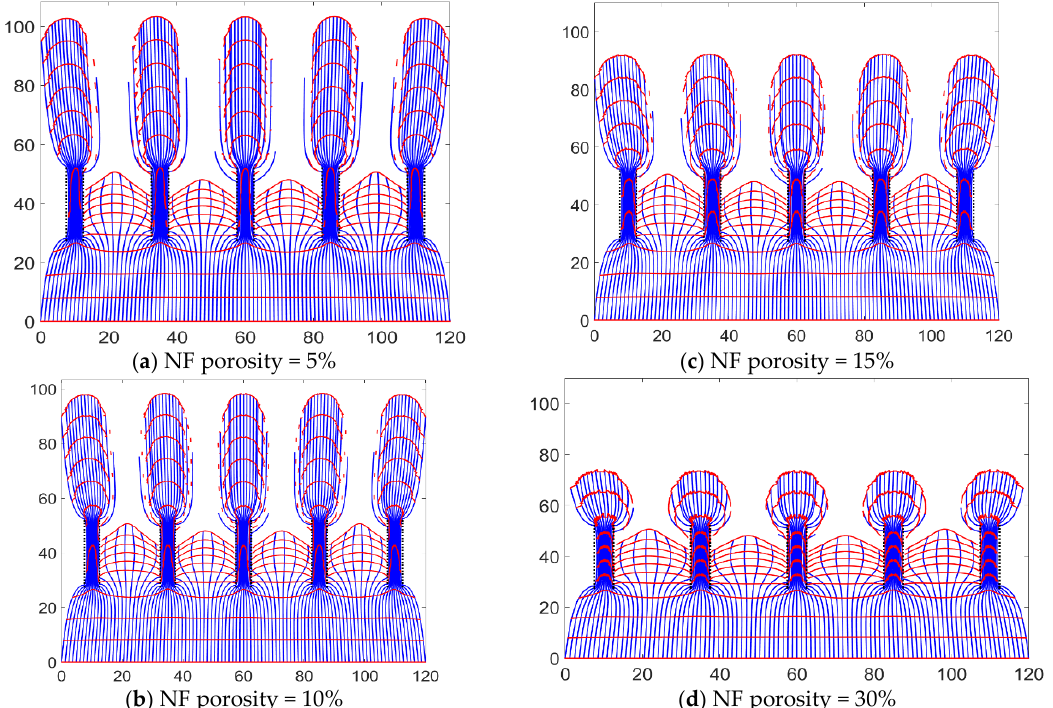
Figure 7. REV model showing e ff ect of various natural fracture (NF) porosity ranging from ( a ) 5% to ( d ) 30% changes in a reservoir space of 5% porosity with enhanced strength in the NF of 500 ft 4 / year. The streamlines are in blue and TOFC are in red. Natural fractures are in